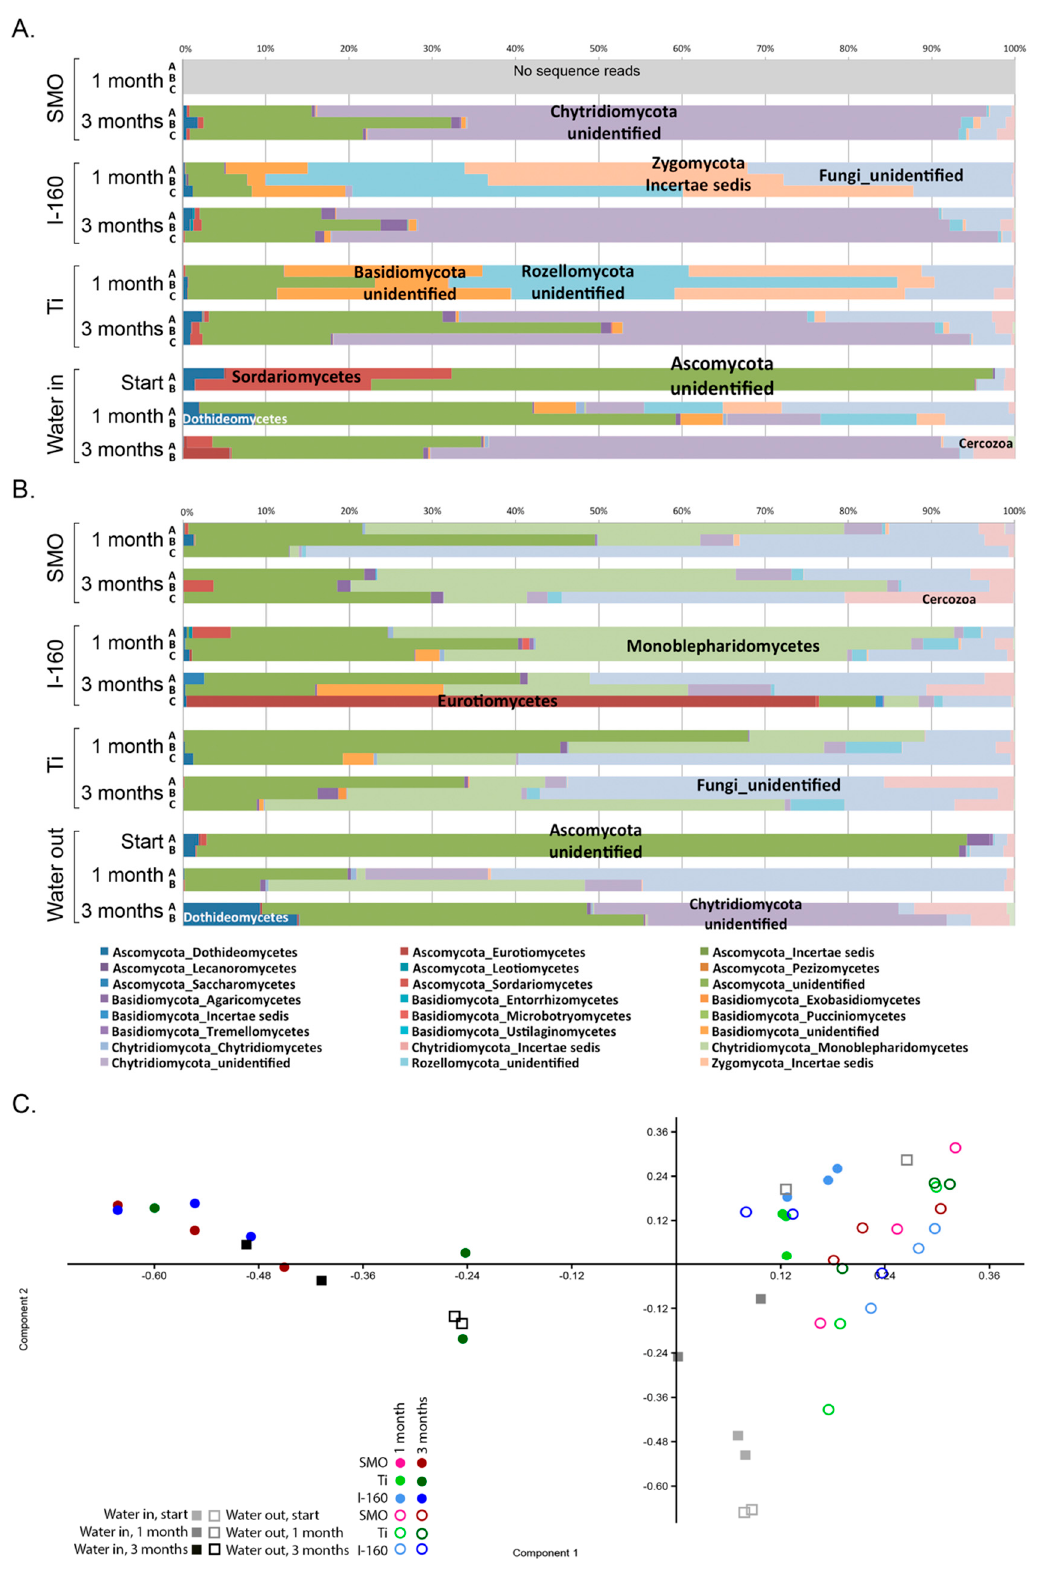
Figure 8. The fungal community composition of ( A ) the non-chlorinated and ( B ) chlorinated samples; ( C ) a PCA plot based on the fungal community (family level). In ( C ), open symbols indicate chlorinated and solid symbols non-chlorinated samples. Component 1 explains 36.7% and Component 2 explains 22.6% of the variance of the variance with Monoblepharidomycetes, unidentified Chytridiomycota and unidentified Fungi determining the loadings of PC1 and unidentified Ascomycota determining the loadings of PC2.